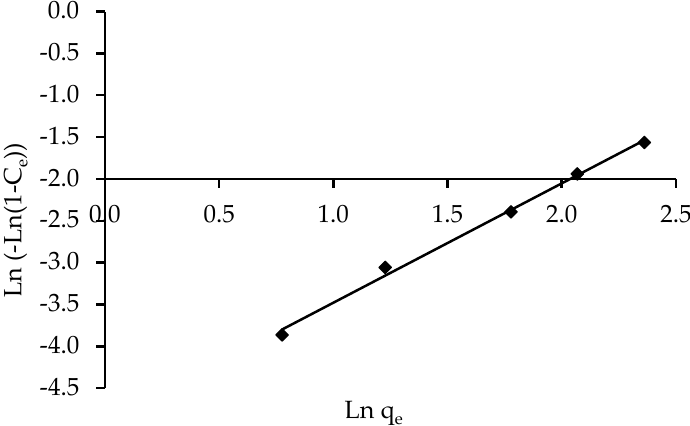
Figure 13. Linear Henderson isotherm of the removal of IV2R by ZnO ‐ NPs.